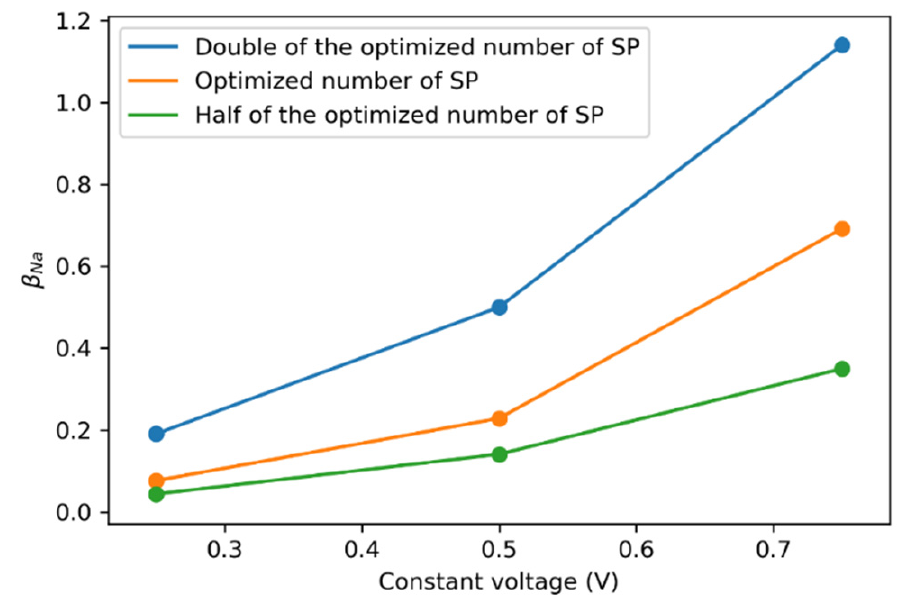
Figure 8. Changes in β Na against varying actual NSP at the constant voltages of 0.75, 0.5, and 0.25 V.